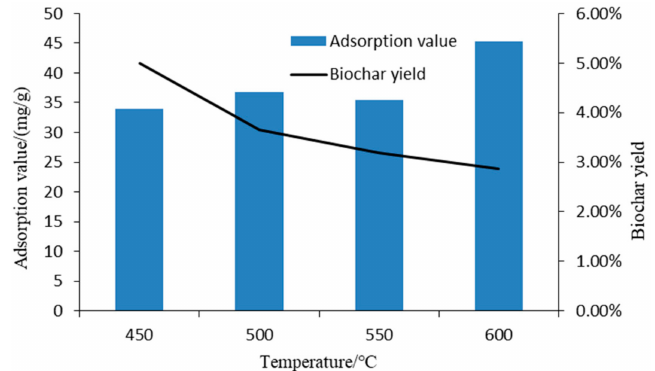
Figure 3. E ff ect of temperature on the biochar yield and adsorbability.